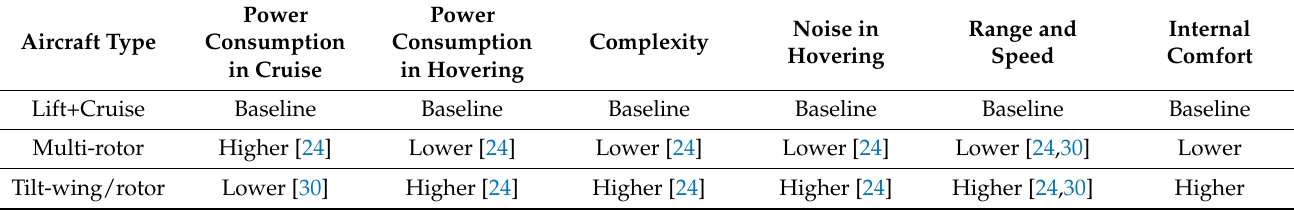
Table 1. Main advantages and drawbacks of different e-VTOL aircraft